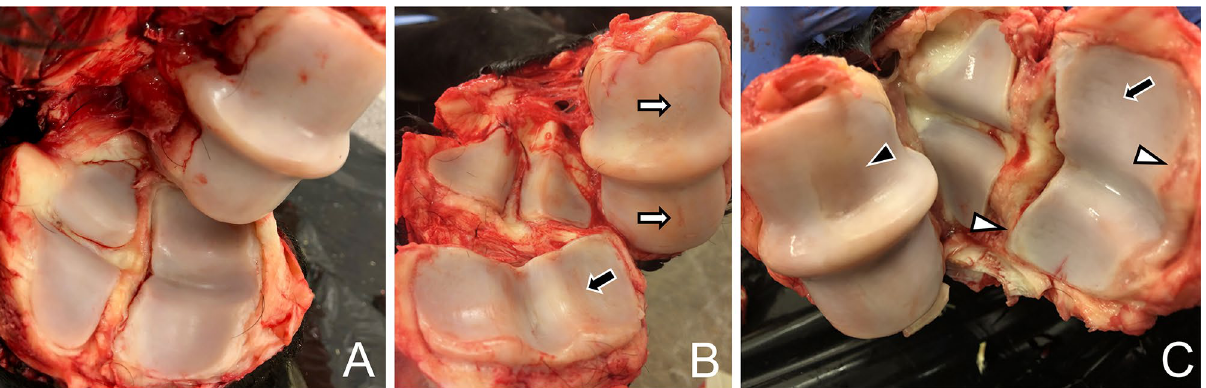
Figure 1. Representative photographs of articular cartilage in normal and osteoarthritic horse fetlock joints. A = normal, B = mild osteoarthritis (OA), C = severe OA, black arrows indicate thinning and wear lines in articular cartilage, white arrows indicate erosion, black arrowhead points to missing cartilage, and white arrowheads indicate